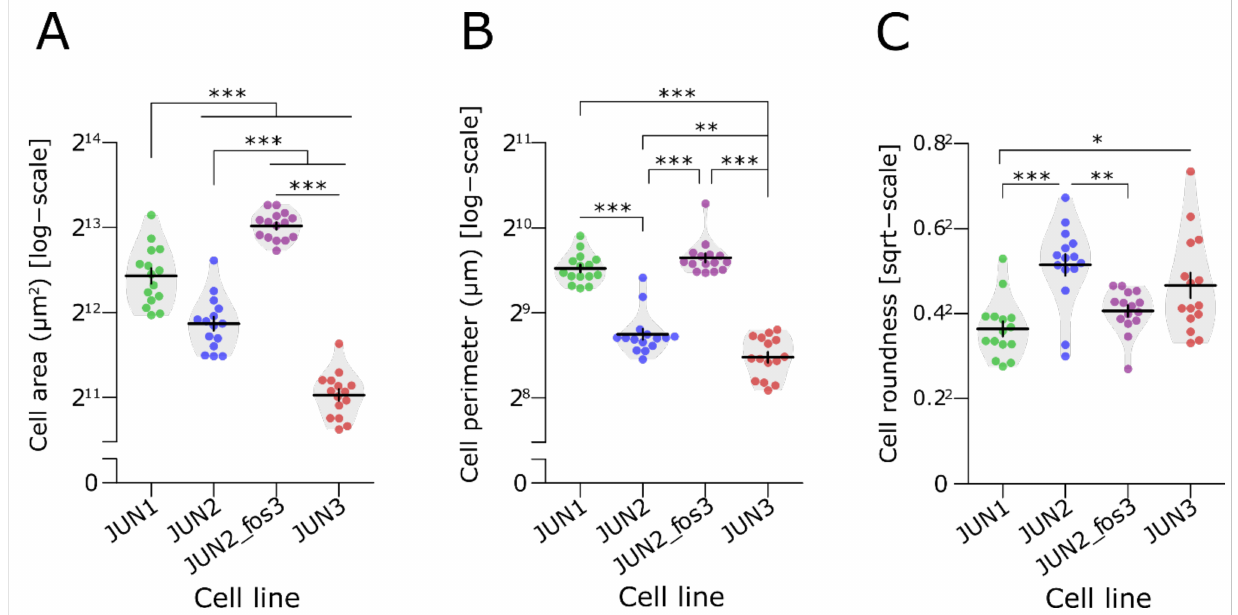
Figure 3. Morphological characteristics of JUN-sarcoma cell lines. ( A – C ) Size analysis of single adherent cells of JUN- sarcoma cell lines. Three parameters were evaluated—the total cell area of an adherent cell ( µ m 2 ; permutational ANOVA: F 3,34 = 3.4, p = 0.021), the cell perimeter ( µ m; permutational ANOVA: F 3,34 = 45, p < 0.001), and the cell roundness (permutational ANOVA: F 3,34 = 3.8, p = 0.018). The JUN-2-fos-3 cell line presented the largest cell size with prominent lamellipodia. * p < 0.05, ** p < 0.01, *** p < 0.001. The statistical significances are based on permutational t-test with FDR correction. See Table S2 for effect sizes, their confidence intervals, and exact p -values. Each point represents an individual cell ( n = 15). Violin plots with means ± SEM are